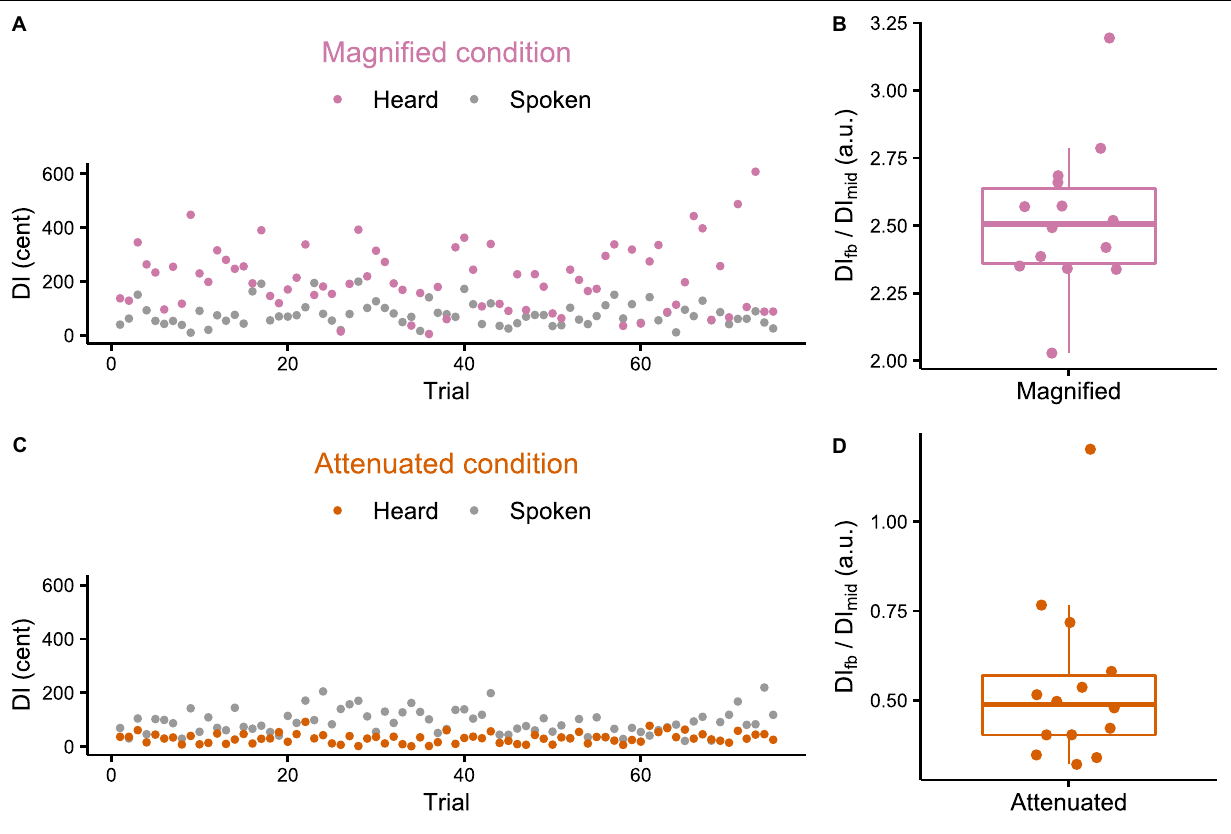
FIGURE 2 | (A,C) Example individual participant data for production and feedback Distance Index (DI) of each trial in the Variability task under Magnified and Attenuated conditions. (B,D) Boxplots with symbols depicting each participant’s ratio between average feedback DI and average production DI (both measured mid-vowel) across all trials of the Variability task with Magnified or Attenuated feedback variability.